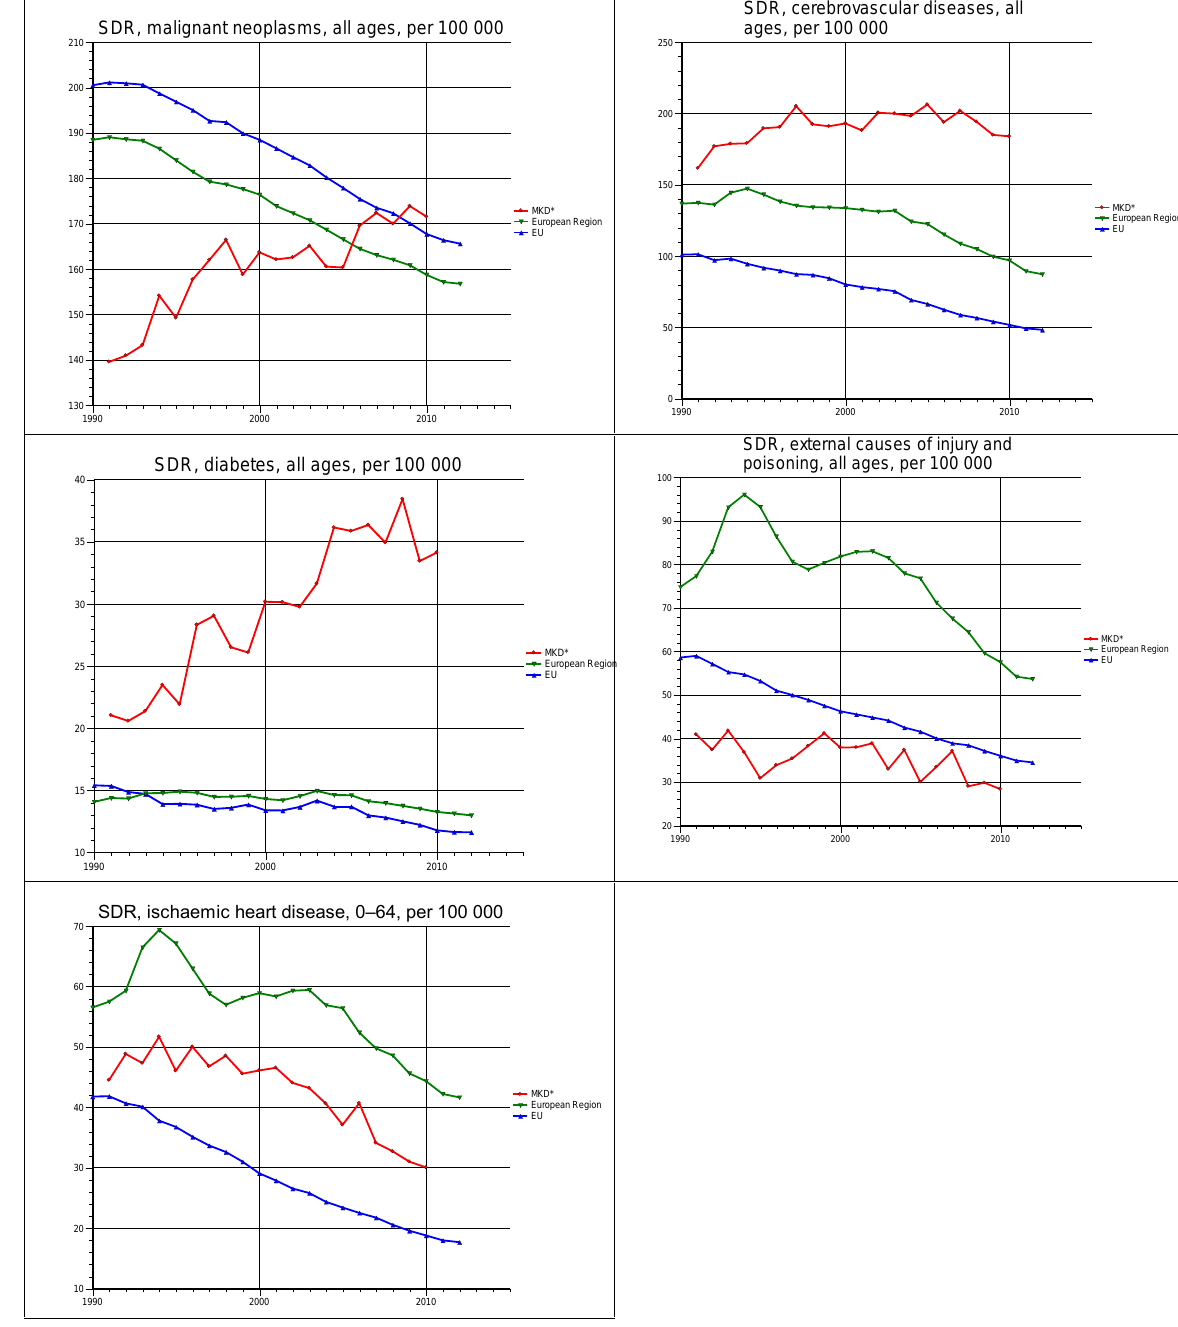
Figure 1. SDR for selected diseases in the Republic of Macedonia during